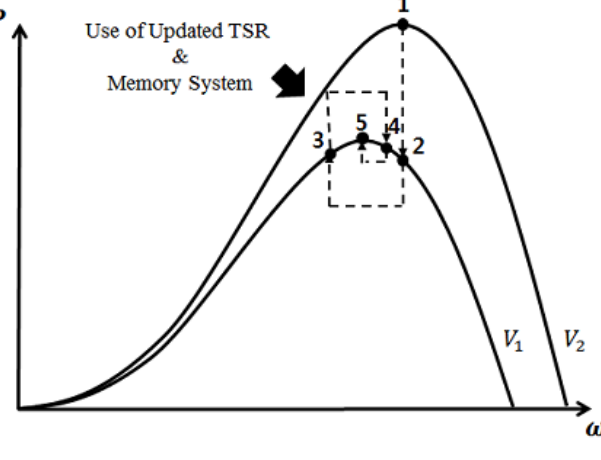
Figure 6. Tracking process of the IHCS